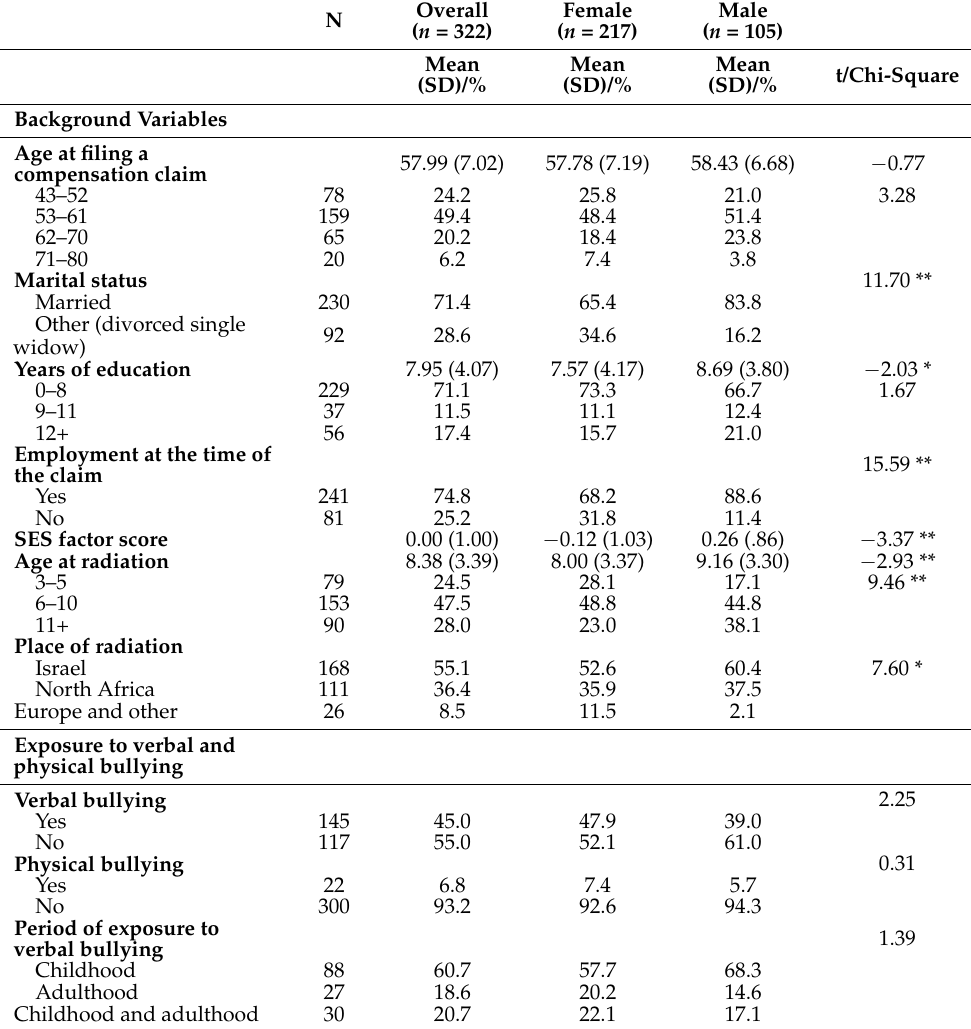
Table 1. Bivariate Analyses of the Study Variables by Gender (N = 322).